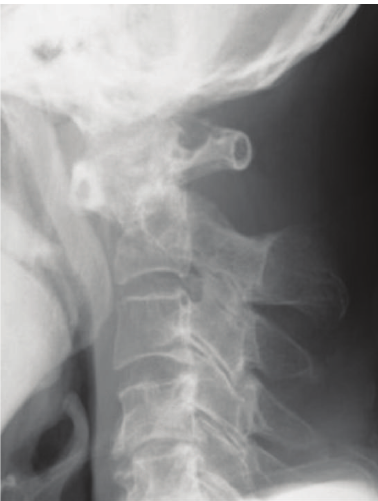
Figure 1: Lateral view of the cervical radiograph showing atlantoax- ial subluxation in the flexion